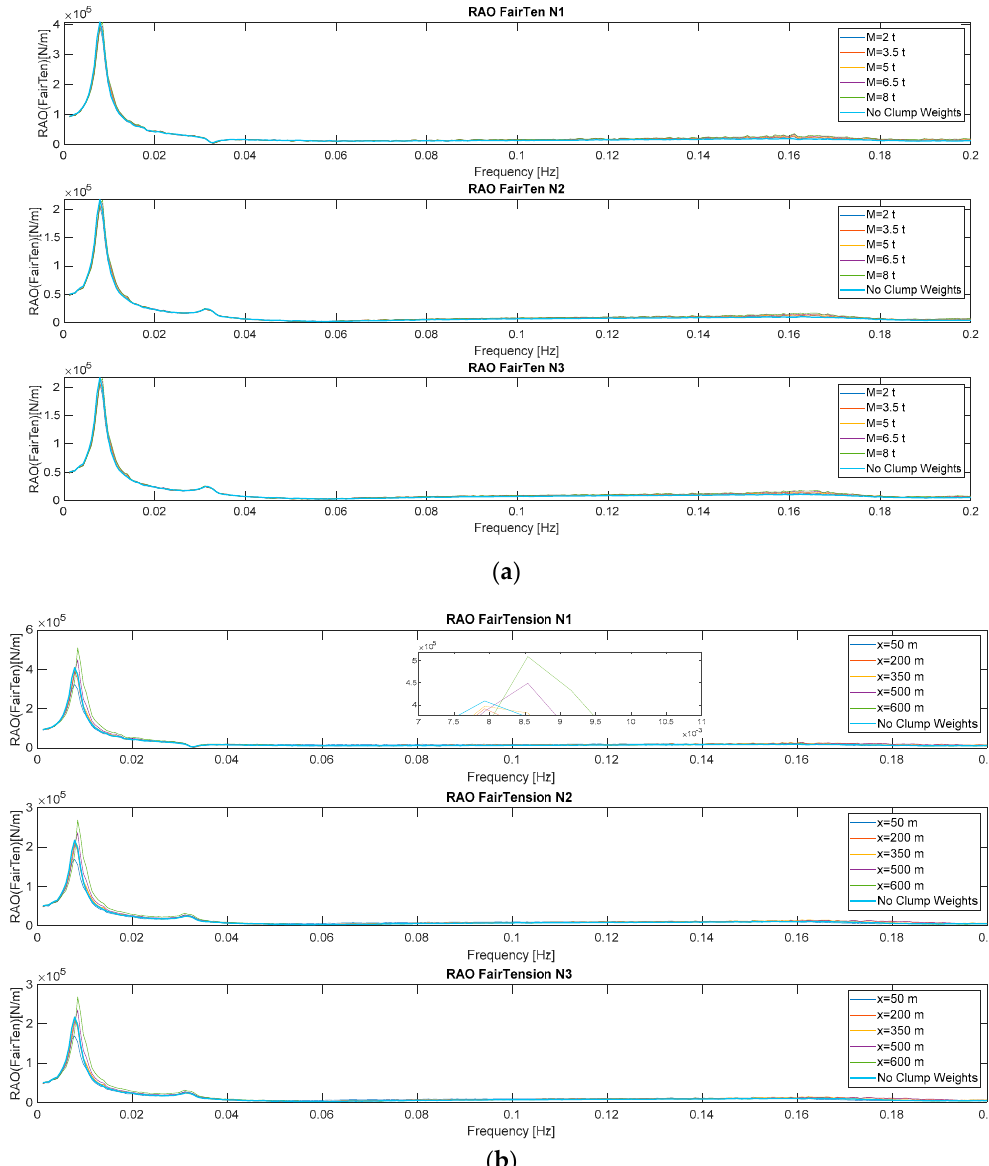
Figure 5. Fairlead Tension RAOs for different weights ( a ) and positions ( b ) of the cable ballast. Each figure shows the Fairlead Tension for every cable.